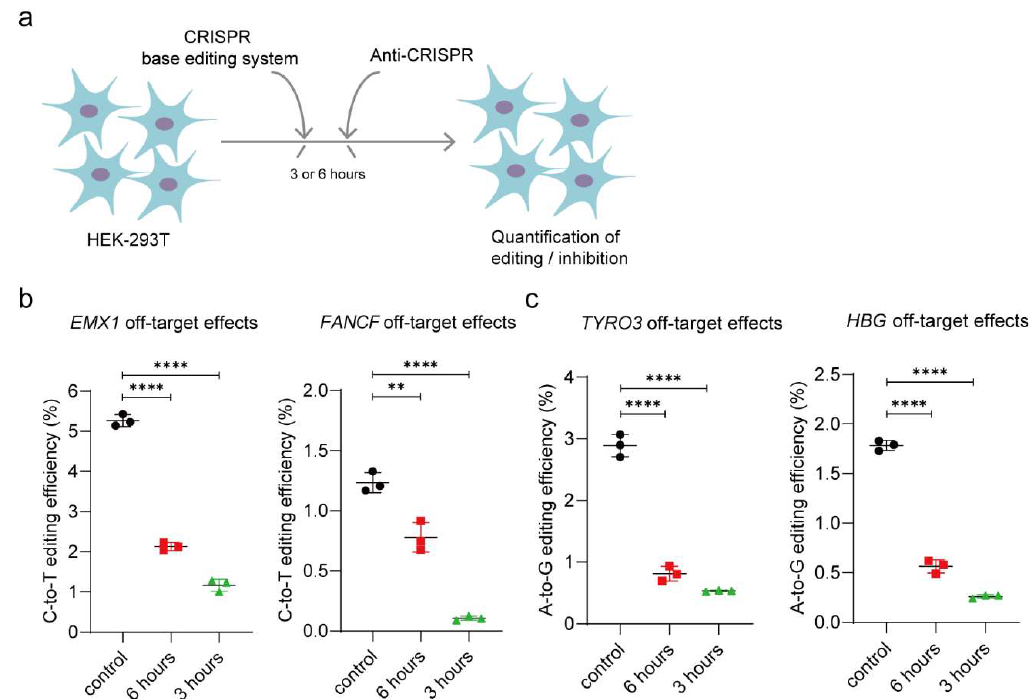
Figure 4. Decreased off-target effects of BE3 or ABE7.10 by AcrIIA5. ( a ) Delivery of AcrIIA5 after